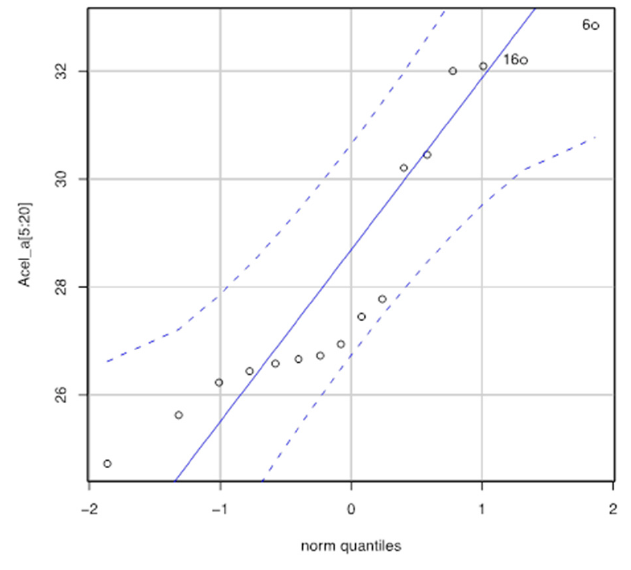
Figure 13. Normal Q–Q plot for Aa.